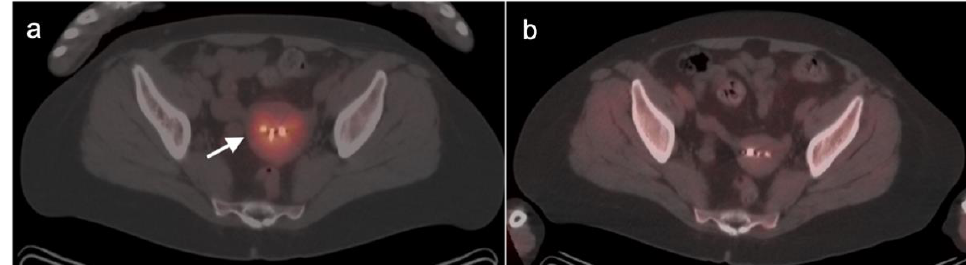
Figure 6. Pelvic inflammatory disease (PID shown on axial FDG PET-CT images of the pelvis. ( a ) For a few weeks following placement of an intrauterine contraceptive device (IUD), patients are at increased risk of developing pelvic inflammatory disease (PID), shown here as increased metabolic activity in the endometrium and myometrium on FDG PET-CT (white arrow). ( b ) A later FDG PET- CT scan shows that the PID and metabolic activity have resolved.